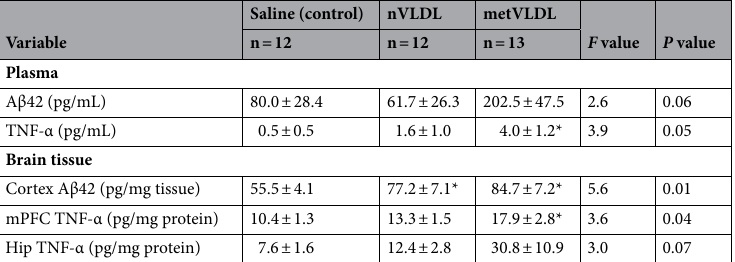
Table 1. Protein expression analysis in mouse plasma and brain after 6 weeks of tail-vein injections with nVLDL, metVLDL, or saline. Aβ42, amyloid beta 42; mPFC, medial prefrontal cortex; Hip, hippocampus; nVLDL, VLDL from healthy volunteers; metVLDL, VLDL from patients with metabolic syndrome. Data are presented as the mean ± standard error of the mean. *p < 0.05 versus control group. P-values were determined by using one-way analysis of variance with the Newman-Keuls post-hoc